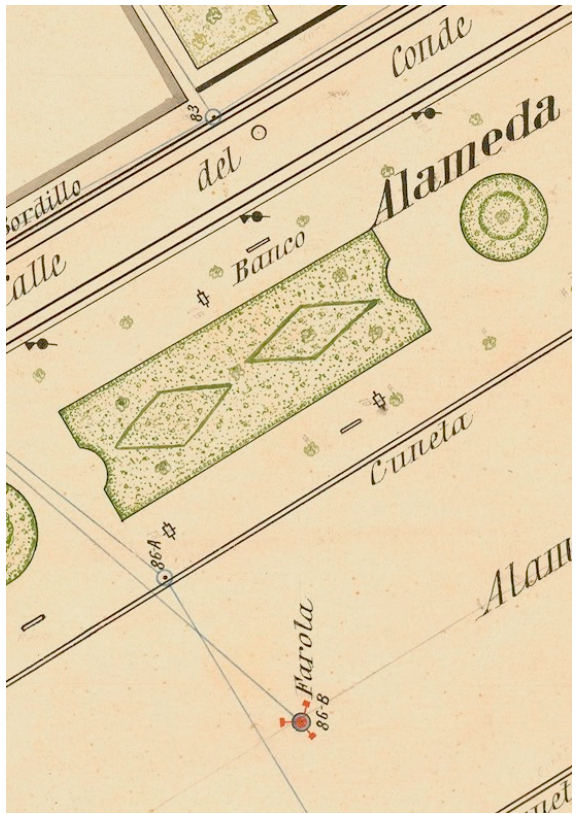
Figure 5. Sample of the 1929 map sheet with the location of the vertex 86A.